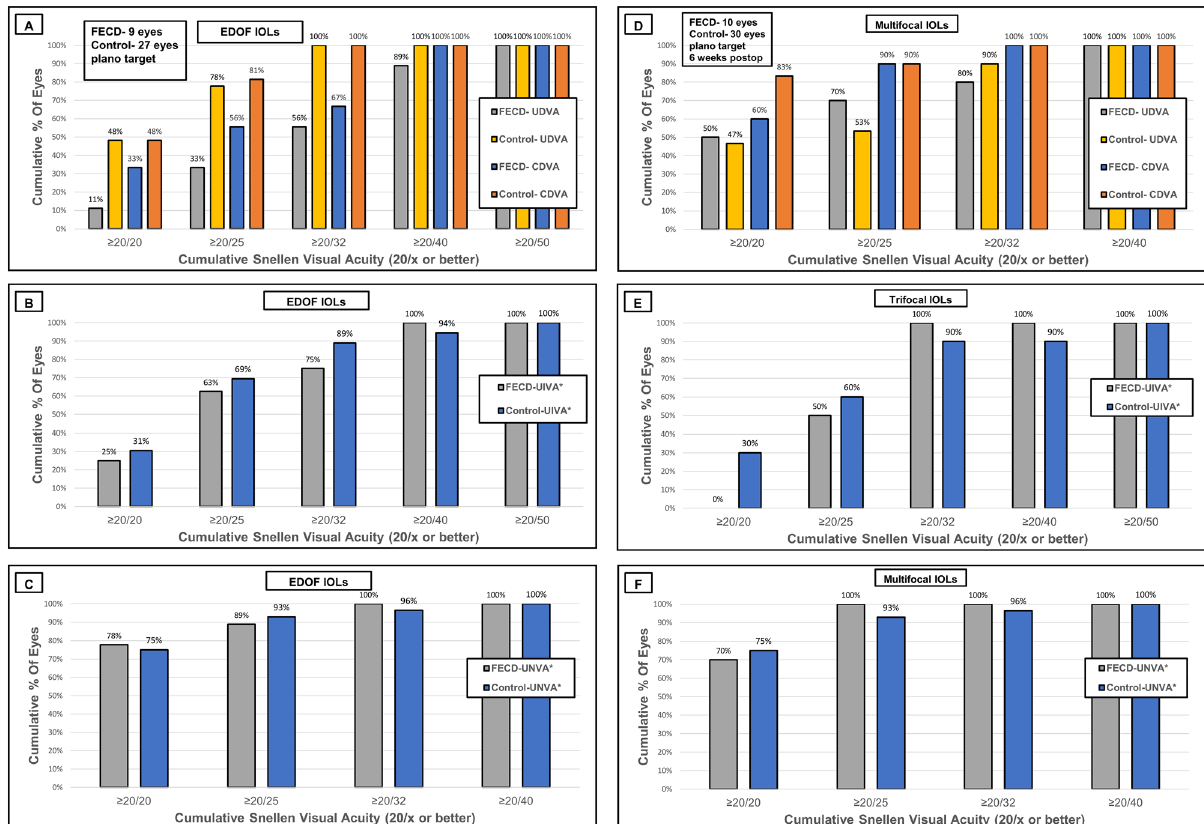
Figure 1. Refractive outcomes EDOF IOL subgroup . ( A ) UDVA and CDVA (Snellen), ( B ) UIVA (Snellen), measured at 80 cm, ( C ) UNVA (Snellen), measured at 40 cm Multifocal IOL subgroup, ( D ) UDVA and CDVA (Snellen), ( E ) UIVA (Snellen), measured at 80 cm, ( F ) UNVA (Snellen) measured at 40 cm (EDOF = extended depth of focus, IOLs = intraocular lenses, UDVA = uncorrected distance visual acuity, CDVA = corrected distance visual acuity, UIVA = uncorrected intermediate visual acuity, UNVA = uncorrected near visual acuity, FECD = Fuchs endothelial corneal